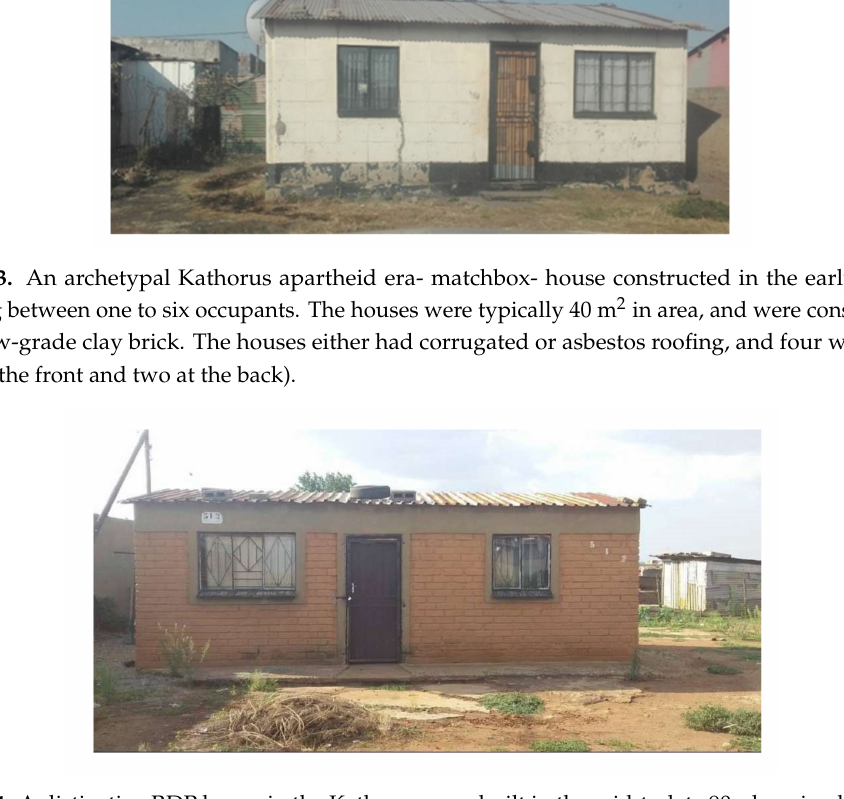
Figure 4. A distinctive RDP house in the Kathorus area, built in the mid-to-late 90s, housing between one to five occupants, with an area of about 36–40 m 2 . The houses were made with cement bricks. The house had asbestos roofs and three windows (at two windows front and one at the